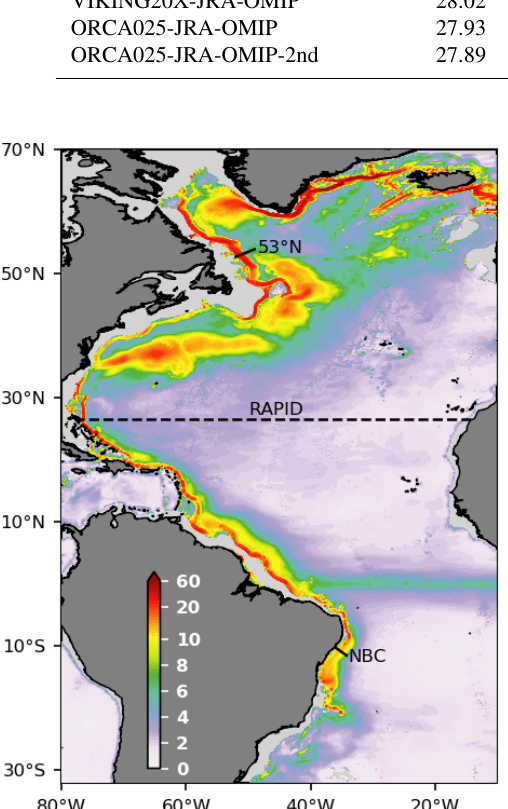
Figure 7. Mean horizontal current speed (1990–2009, in cms − 1 ), averaged between σ 0 = 27 . 65–27.95 in VIKING20X-JRA-short. Regional sections are indicated by black